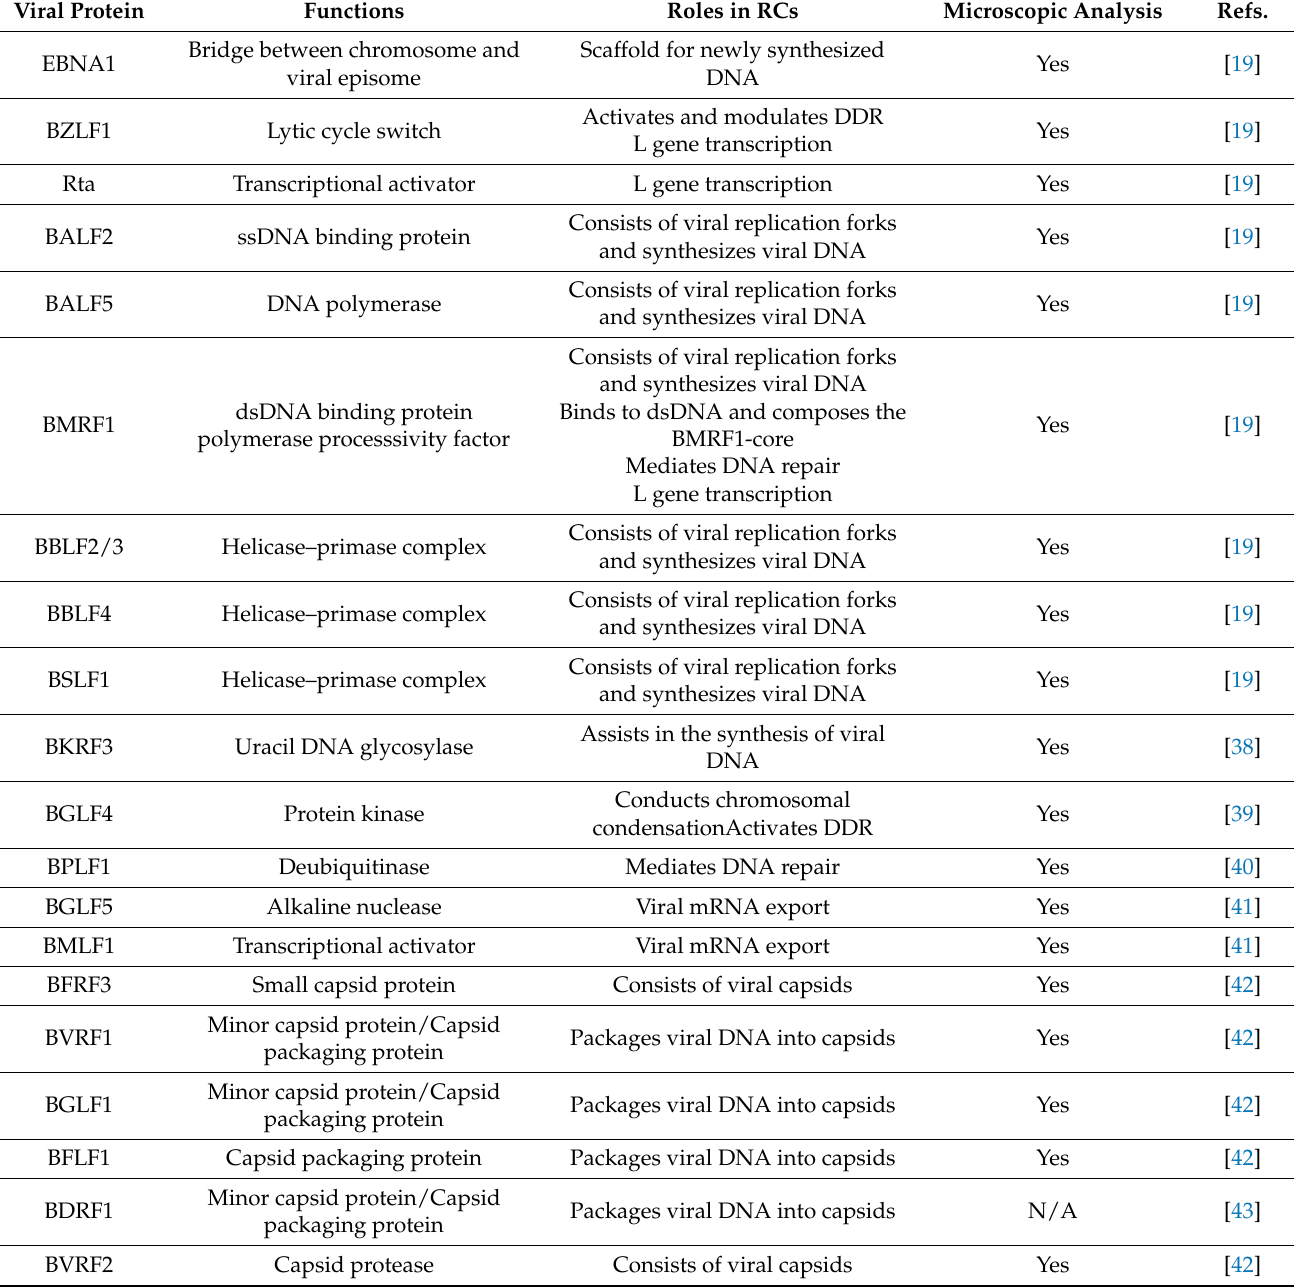
Table 1. Viral proteins accumulate to RCs. “Microscopic analysis” means that the localization to RCs of the viral protein was improved by IFA. “N/A” indicates that the localization to RCs of the viral protein was not improved by IFA but that it was estimated to accumulate in RCs by co-immunoprecipitation analysis with viral proteins recruited to RCs or other functional